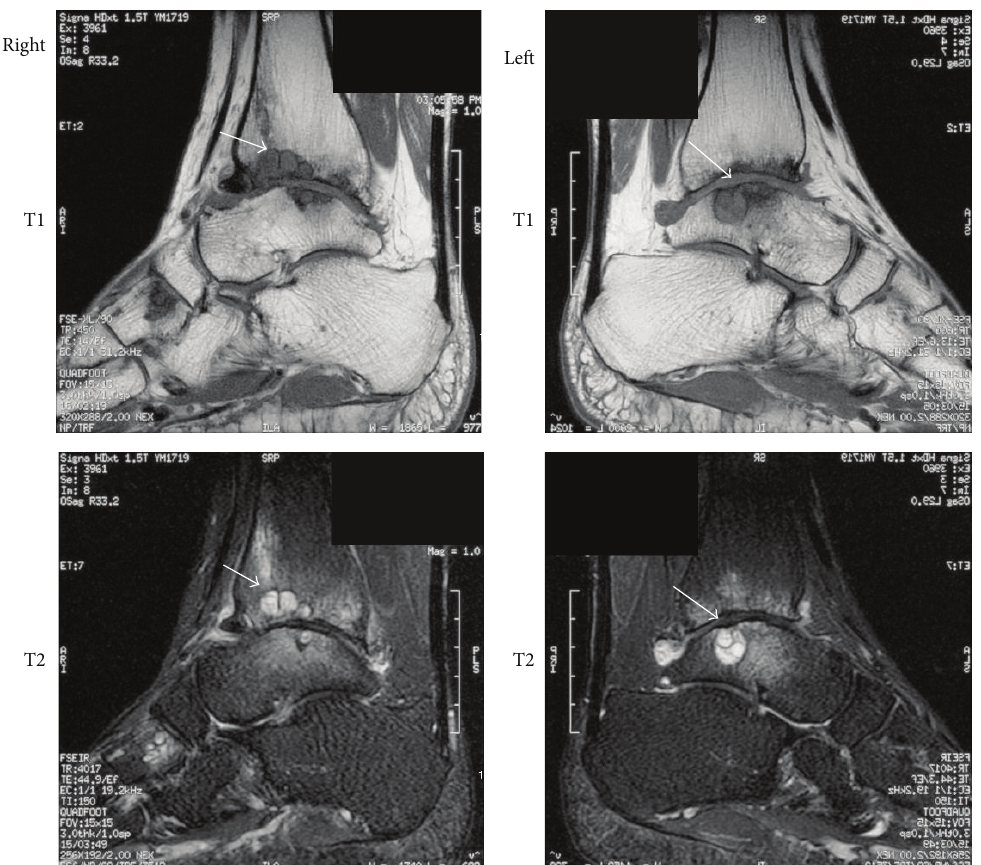
Figure 2: Magnetic resonance imaging (MRI) of both the ankles. Arrows show cystic lesions in both the tibia and talus. Degenerative change is also seen in right